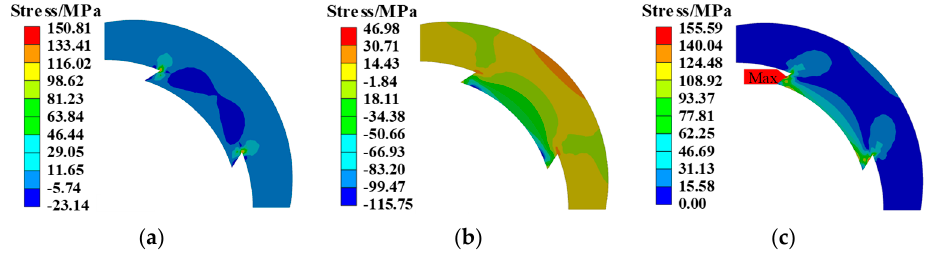
Figure 15. Distribution of PM stress with SIPM1. ( a ) Radial stress. ( b ) Tangential stress. ( c ) Equivalent stress.